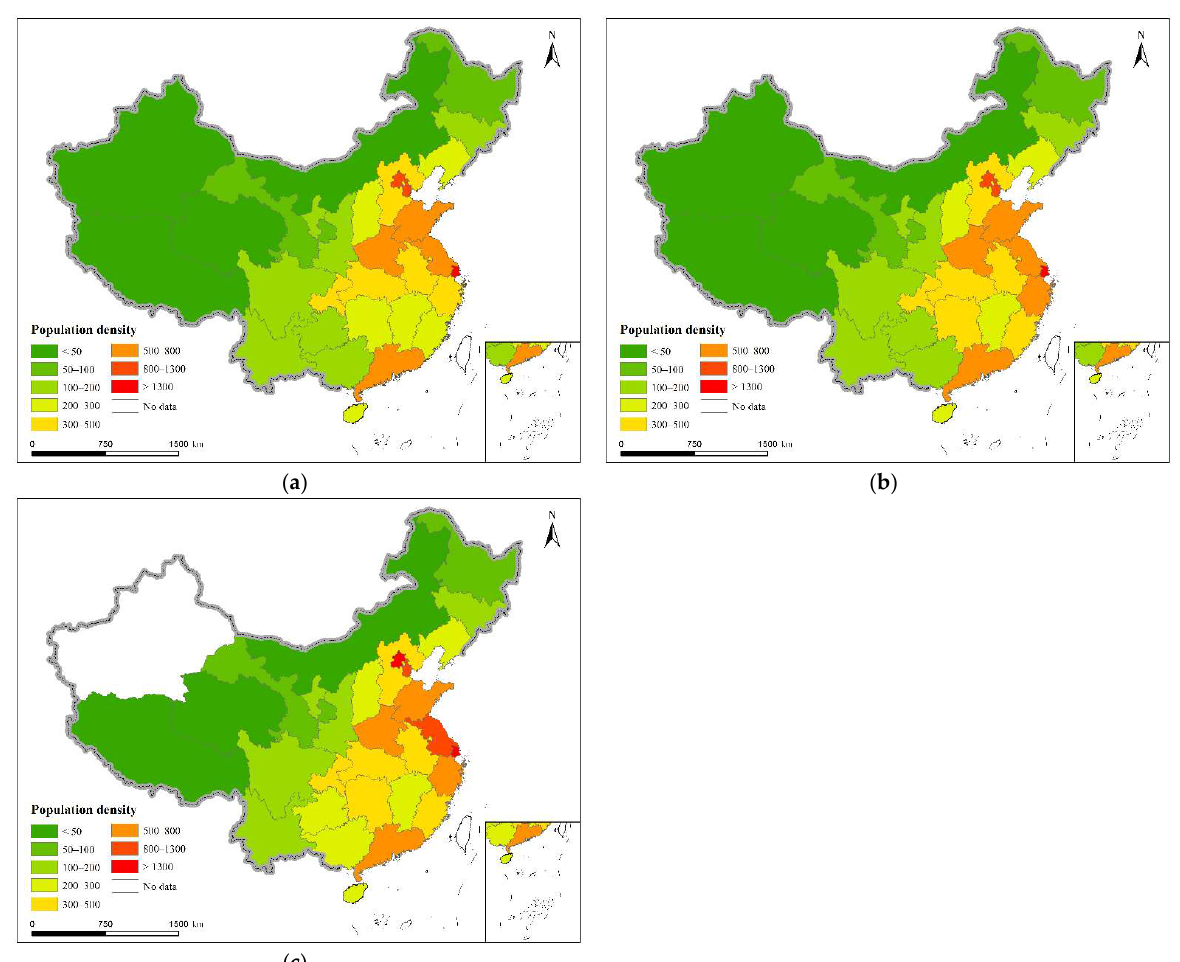
Figure 5. Results of the average population density for the urban level in China in ( a ) 2000, ( b ) 2010,